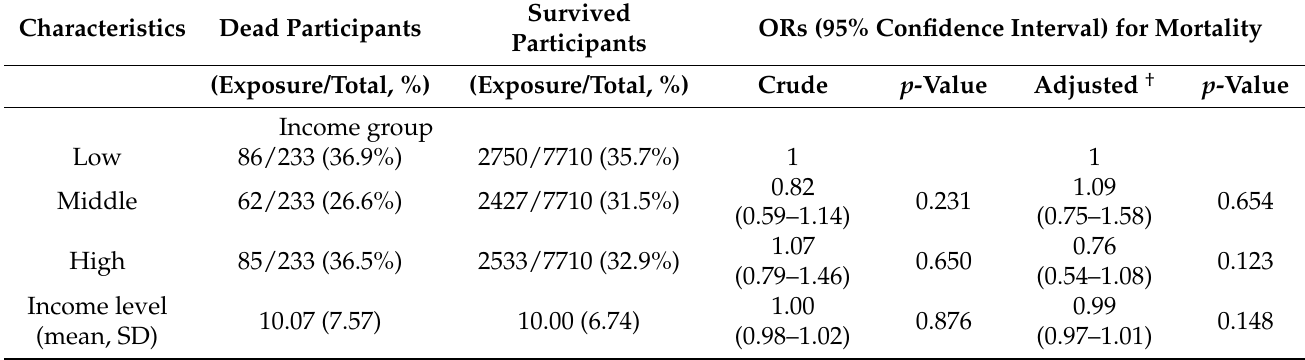
Table 4. Crude and adjusted odds ratios of the association of income with mortality in COVID-19 participants.